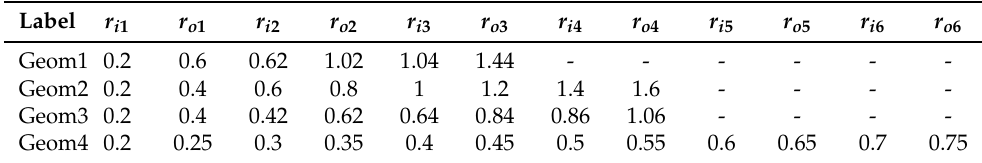
Figure 1. Geometry of the problem: Q coplanar perfectly conducting concentric rings, with inner and outer radii r iq and r oq , respectively, for q = 1 . . . Q . A plane wave impinges on the rings with an incidence angle θ inc with respect to z axis. Due to the symmetry the azimuthal angle of incidence is not essential. Table 1. List of configurations analyzed throughout the paper. All dimensions are normalized to the